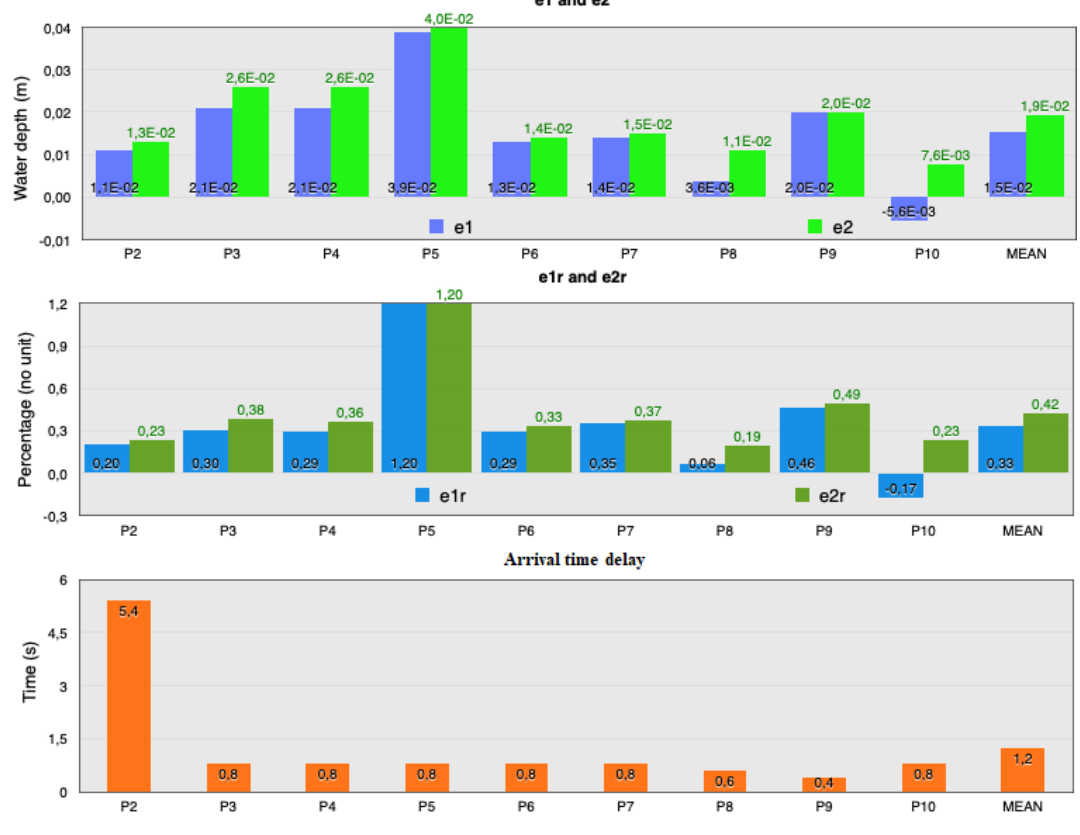
Figure 15. Metrics with respect to the gauge stations and their mean values.